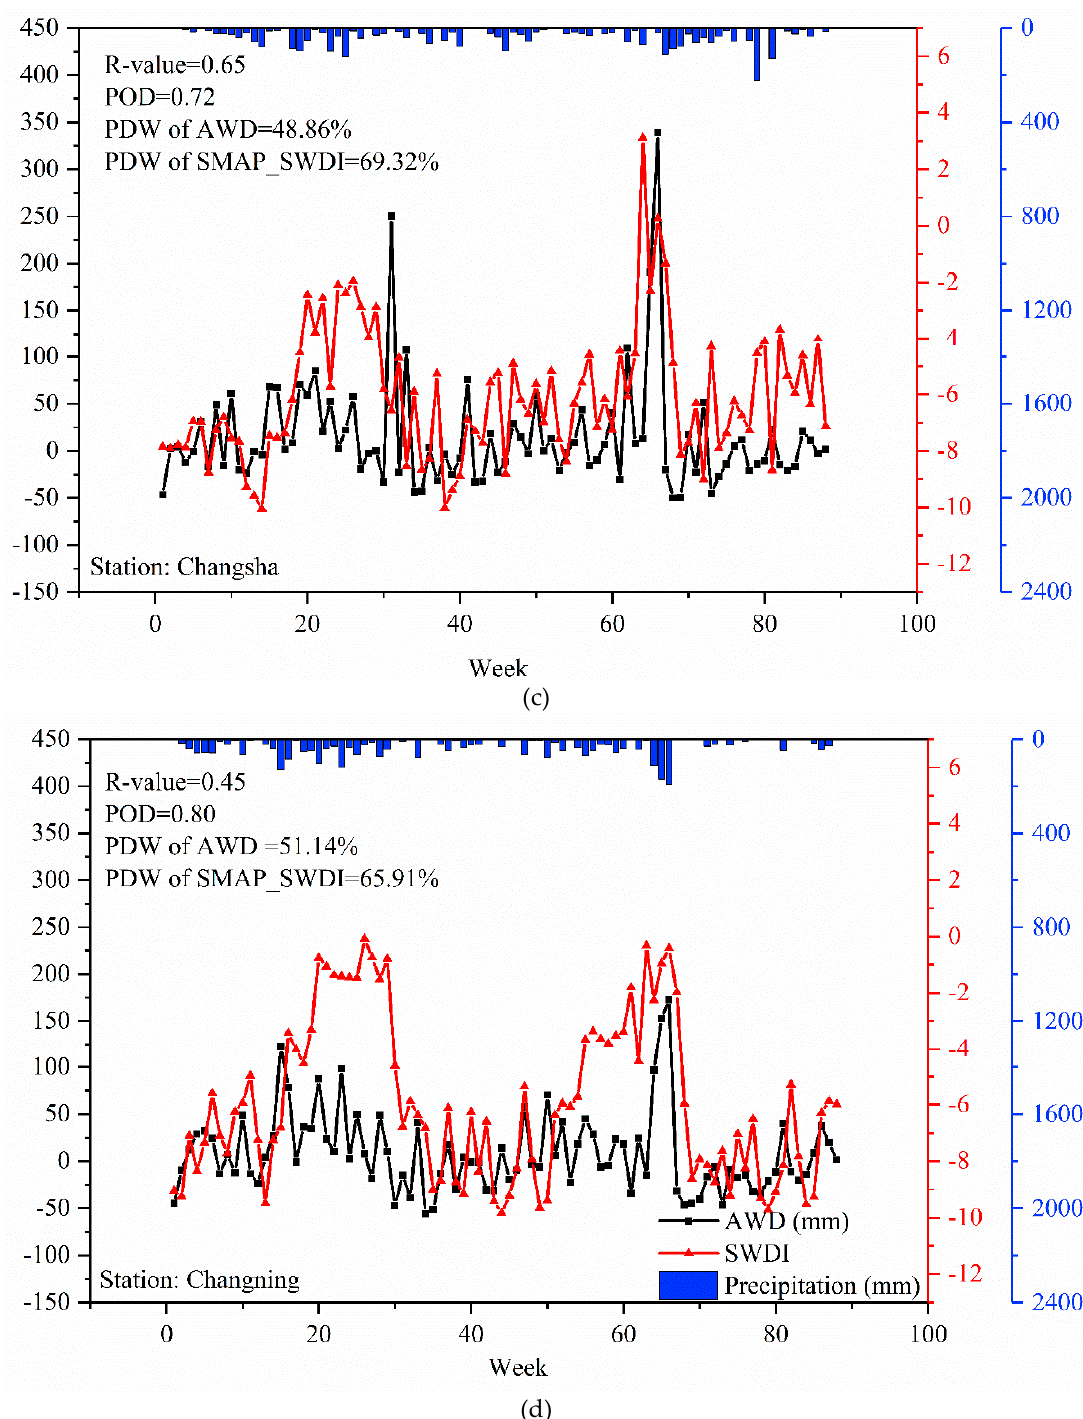
Figure 10. Time series of weekly rainfall, SMAP_SWDI and AWD for four of the 13 sites. Table 2. Values of CC, POD, and PDWs of AWD and SMAP_SWDI in different stations. Station